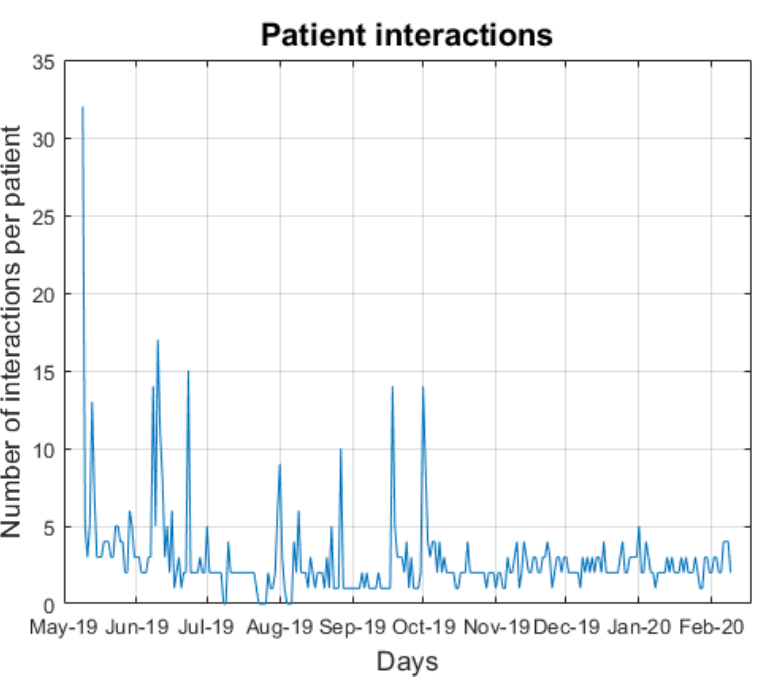
Figure 3. Patient interactions with the virtual assistant over time (normalized by the number of active patients).